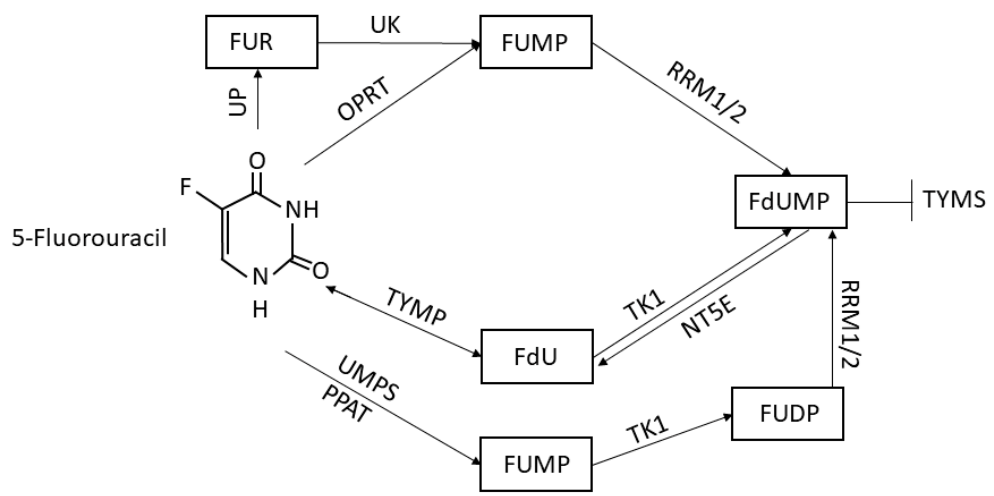
Figure 1. A simplified diagram of the 5-fluorouracil (5FU) conversion system. Uridine phosphorylase (UP), uridine kinase (UK), fluorouridine (FUR), orotate phosphoribosyltransferase (OPRT), fluorouridine monophosphate (FUMP), ribosyl reductase complexes (RRM1/2), fluorodeoxyuridine monophosphate (FdUMP), thymidylate synthase (TYMS), thymidine phosphorylase (TYMP), fluorodeoxyuridine (FdU), thymidine kinase 1 (TK1), nucleotidase (NT5E), uridine monophosphate synthase (UMPS), phosphoribosyl pyrophosphate amidotransferase (PPAT), and fluorouridine diphosphate (FUDP).